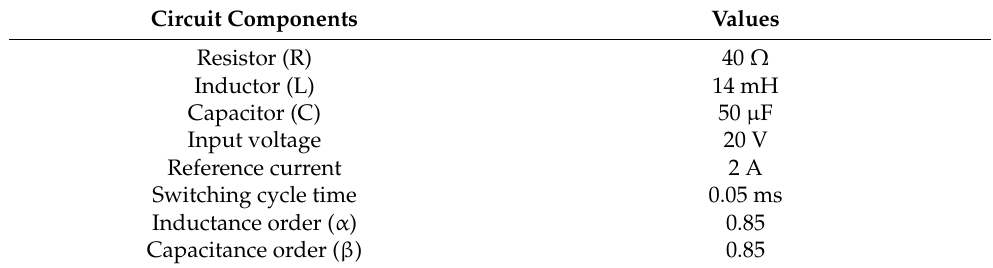
Table 1. The circuit parameters.